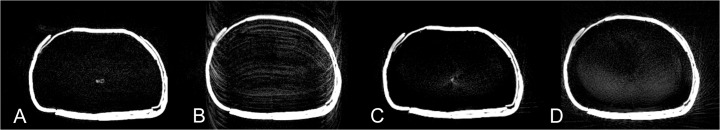
The phantom scanned by MR imaging with the cartesian wsTSE sequence without (A) and with breathing simulation (B) and the PROPELLER wsTSE sequence without (C) and with breathing simulation (D).